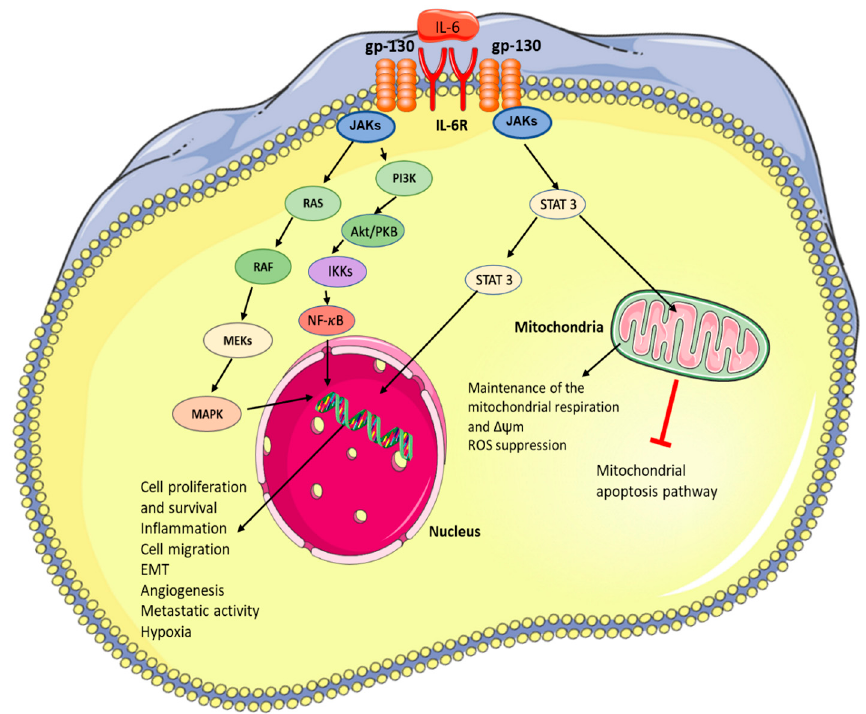
Figure 4. Influence of IL-6 signalling on cancer development and metastasis formation. The figure was created using Servier Medical Art available at http://smart.servier.com/ (accessed on 15 August 2022). Table 1. Examples studied agents for the inhibition of IL-6 signalling with an emphasis on their clinical